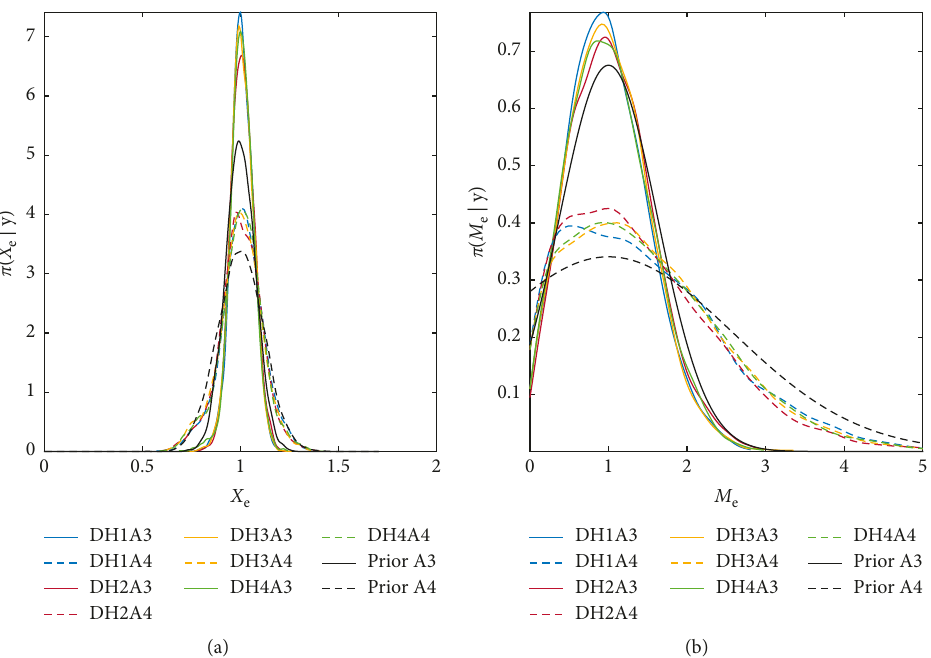
Figure 10: Anomaly scenarios A3 and A4. Prior covariance matrix with λ